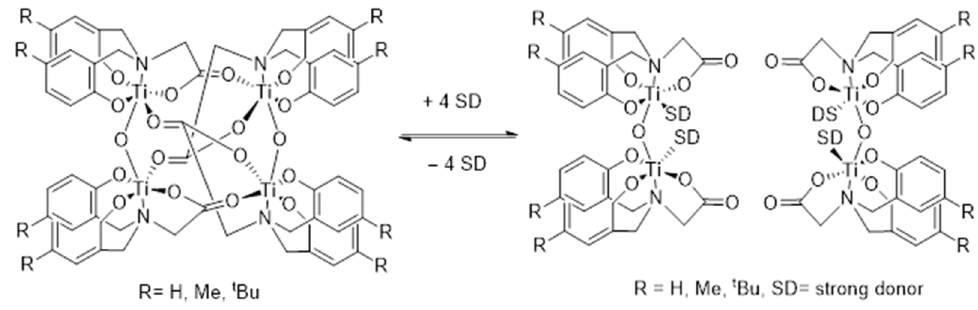
Figure 1. Dissociation between tetranuclear Ti cluster ((Ti 2 O) 2 L 4 ) ( left ) and binuclear variant ( right ).